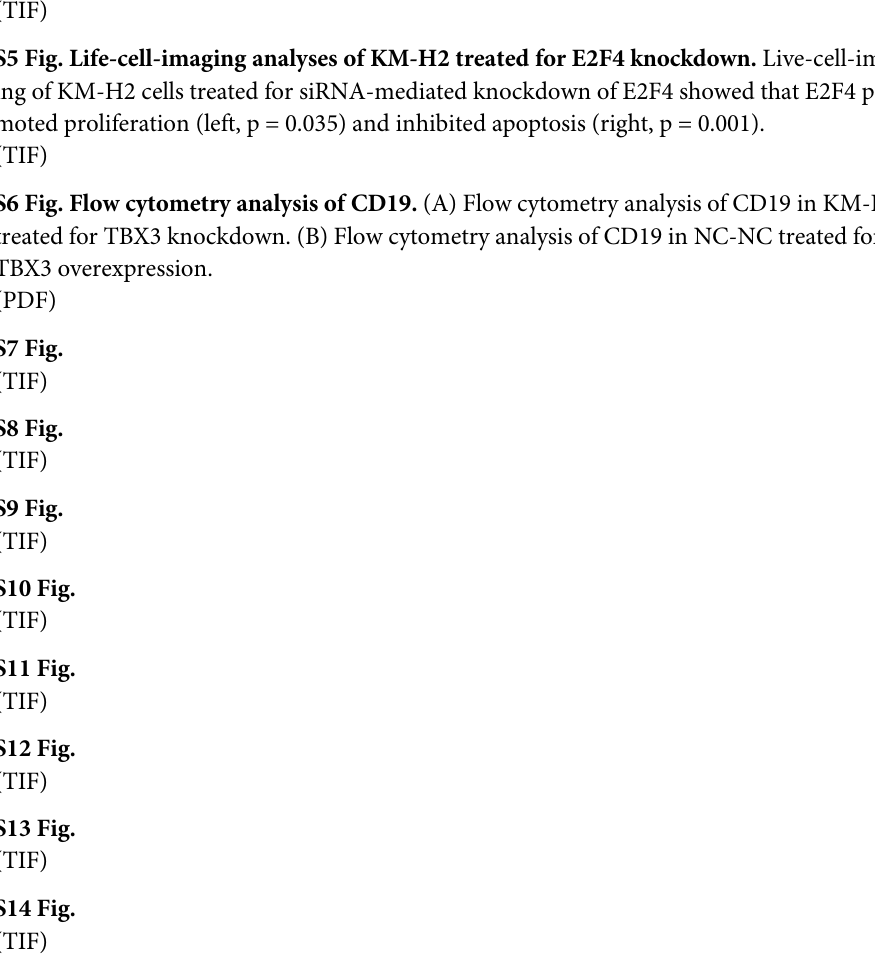
S1 Table. Comparative gene expression profiling analysis of HL cell lines (GSE115191). Gene expression profiling data of eight HL cell lines are indicated, highlighting KM-H2 by a gray background. Line DH451SU gives medium expression levels for control cell lines DEV, differential gene expression levels between KM-H2 and the controls. S2 Table. GO-term analysis of top-1000 downregulated genes in KM-H2. Expression profil- ing analysis of HL cell line KM-H2 in comparison to seven control cell lines revealed differen- tially expressed genes (see S1 Table). The top-1000 downregulated genes in KM-H2 were analyzed using the DAVID online tool generating a list of GO terms. This list indicates deregu- lated functions in KM-H2, including regulation of growth, regulation of B-cell differentiation, and regulation of apoptotic signaling pathways (arrow